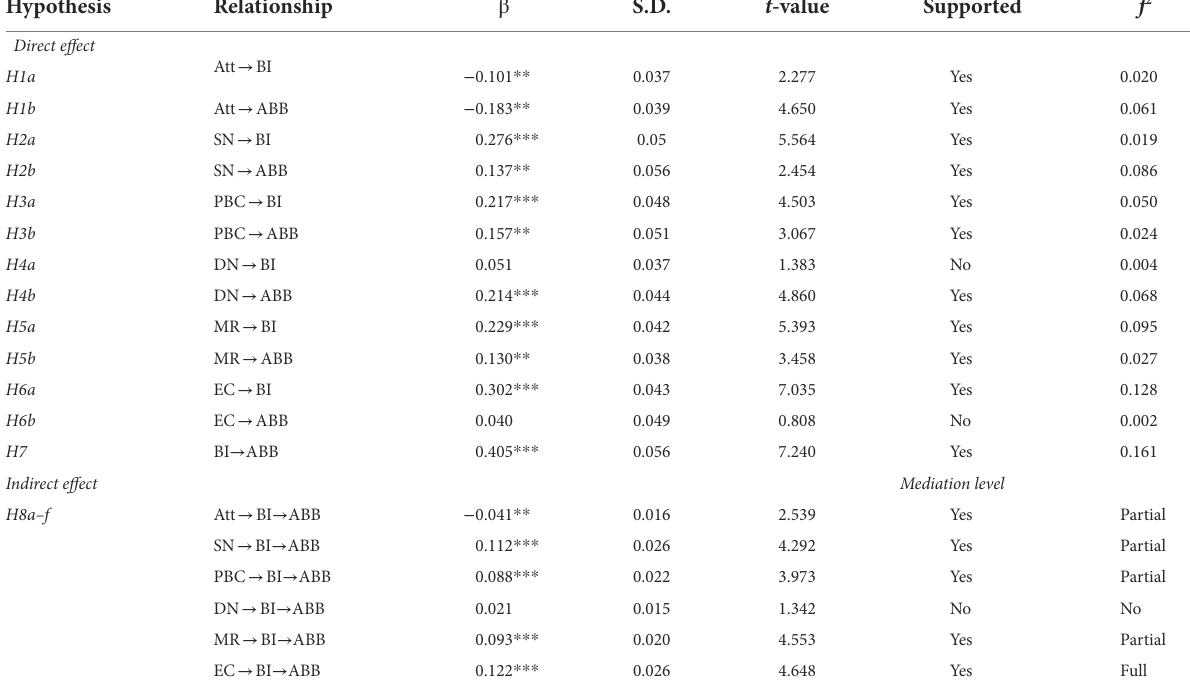
TABLE 4 Results of the structural model, common method bias, and model fit.